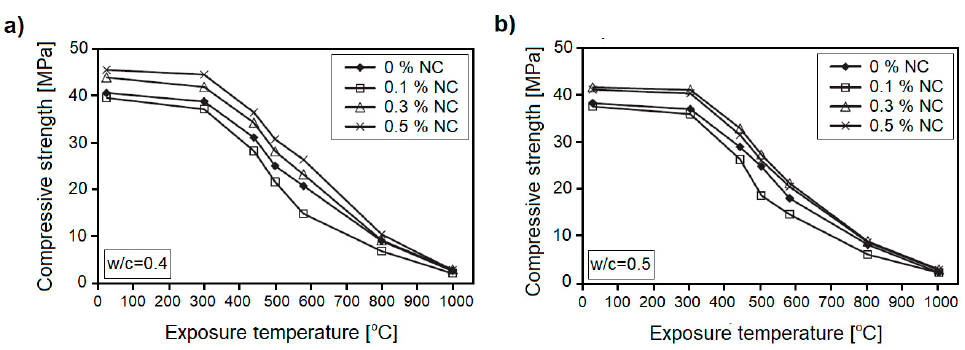
Figure 11. Compressive strength of nanoclay-modified concrete with w/c = 0.4 ( a ) and w/c = 0.5 ( b ) after thermal exposure. Reproduced with permission from [67]. Copyright Elsevier, 2017.